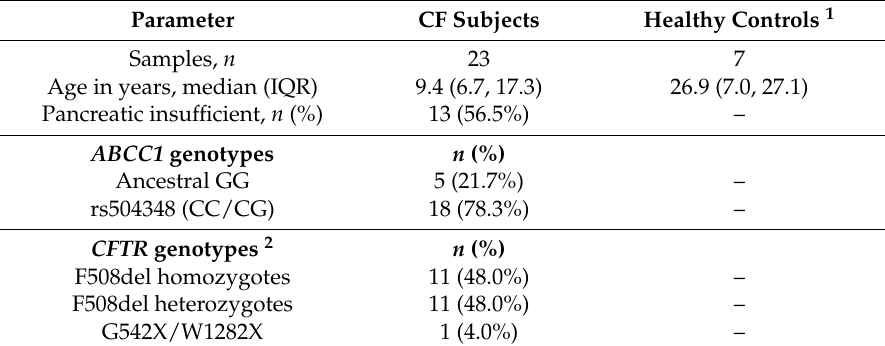
Table 4. Clinical and demographic information for subjects included in expression analysis.